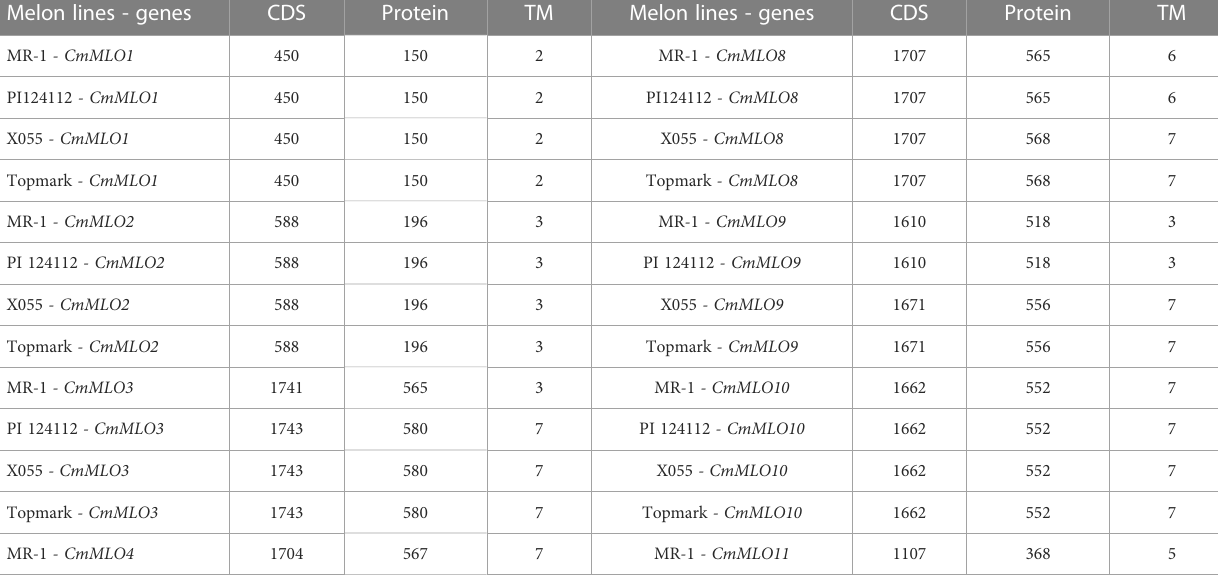
TABLE 3 The detailed information of CDS and protein length of the CmMLO genes. Melon lines -